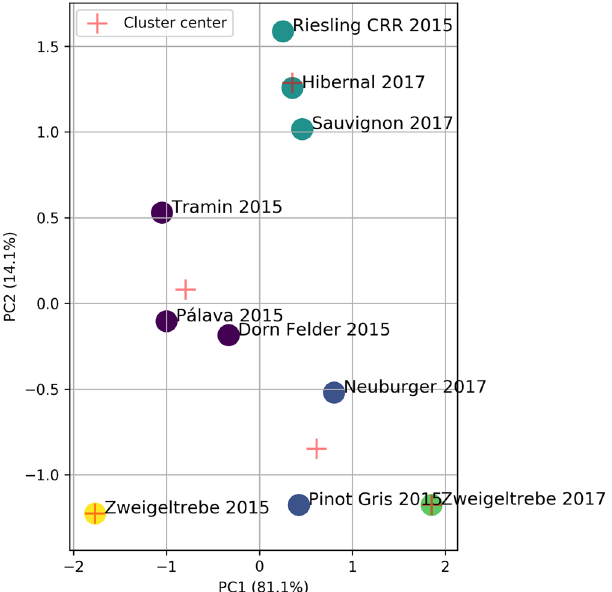
Figure 5. k-Means clusters for standardized PCs in analysis for data of FTIR spectra.